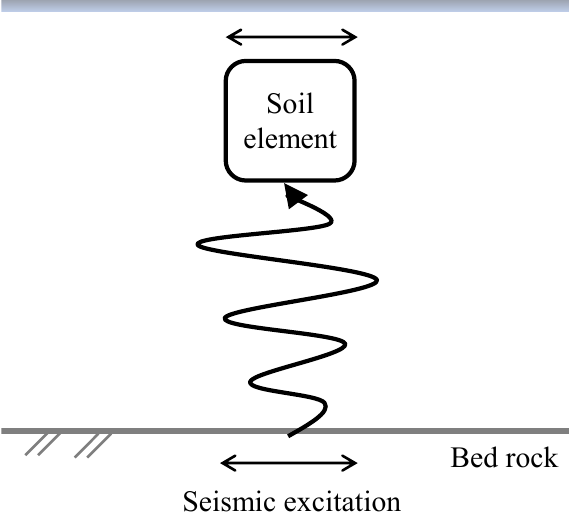
Figure 1. Earthquake wave transmission.